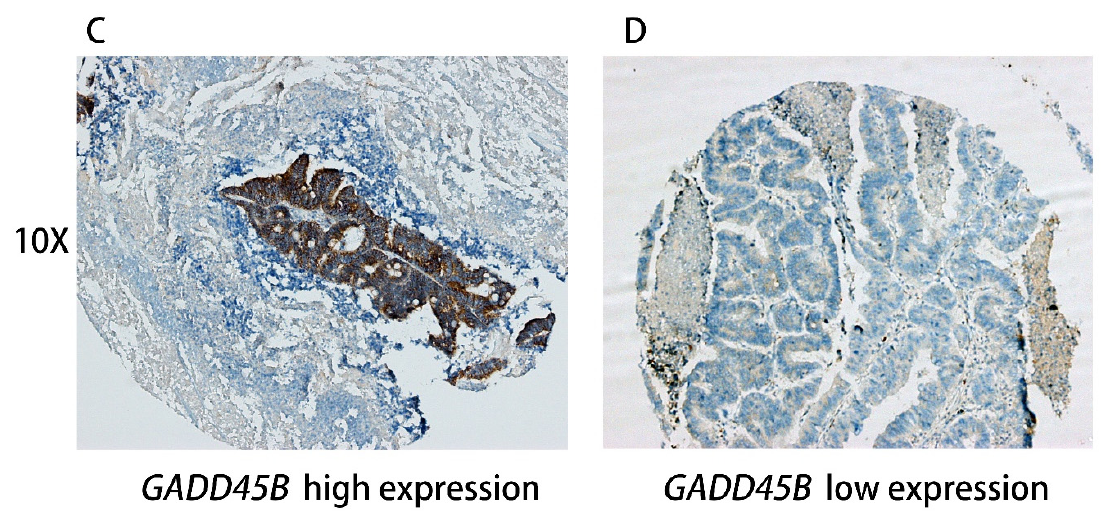
Figure 1. Representative Immunohistochemistry staining pictures of GADD45B expression in colorectal cancer tissues. Tissue high expression (4× for ( A ), 10× for ( C )) and low expression (4× for tissue ( B ), 10× for ( D )) for the GADD45B protein are shown. Each of the punched samples is 1.0 mm in length in the tissue microarrays.